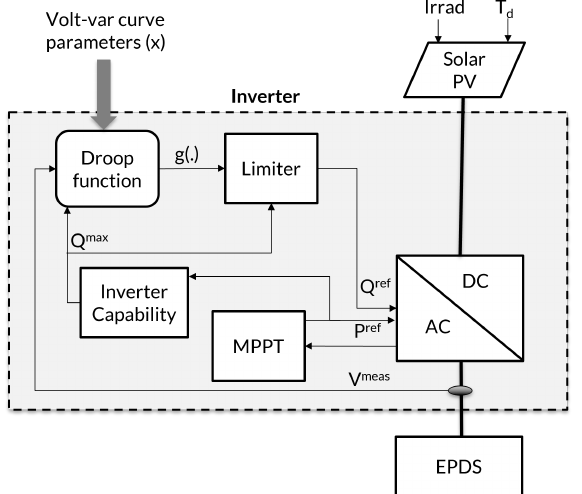
Figure 4. The overview of the prosumer based PV inverter control system. The volt-var curve parameters ( x ) is changed by the cell operator. This is the node level optimization of the